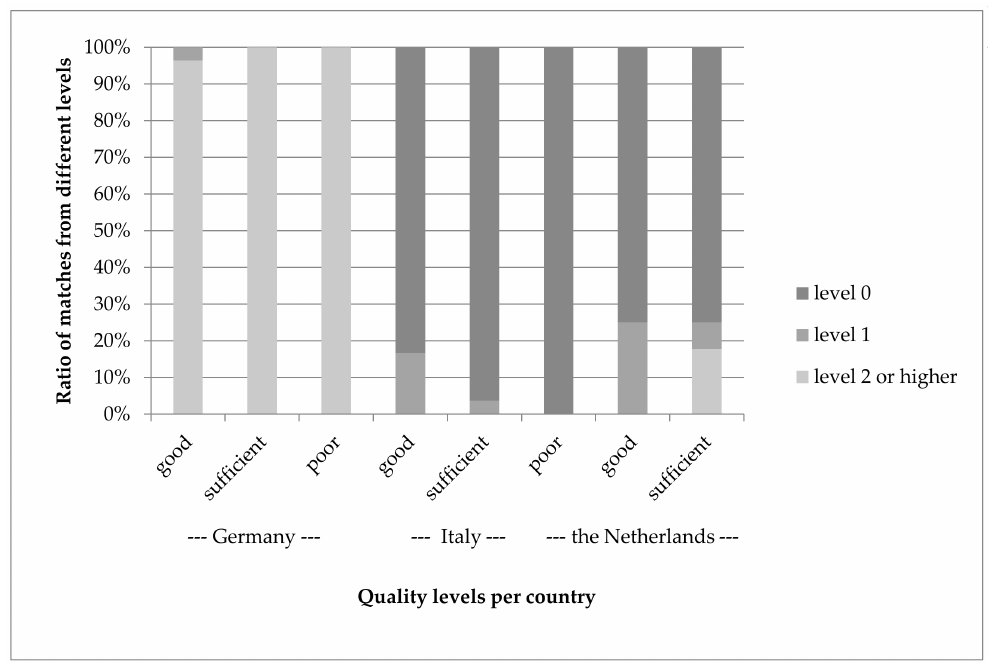
Figure 7. Distribution of quality levels such as indicated by the matching tool (level 0 = best quality) for foods with good, sufficient and poor match as judged by the human expert for three countries. For UK only level 0 matches were proposed so these are not included in the